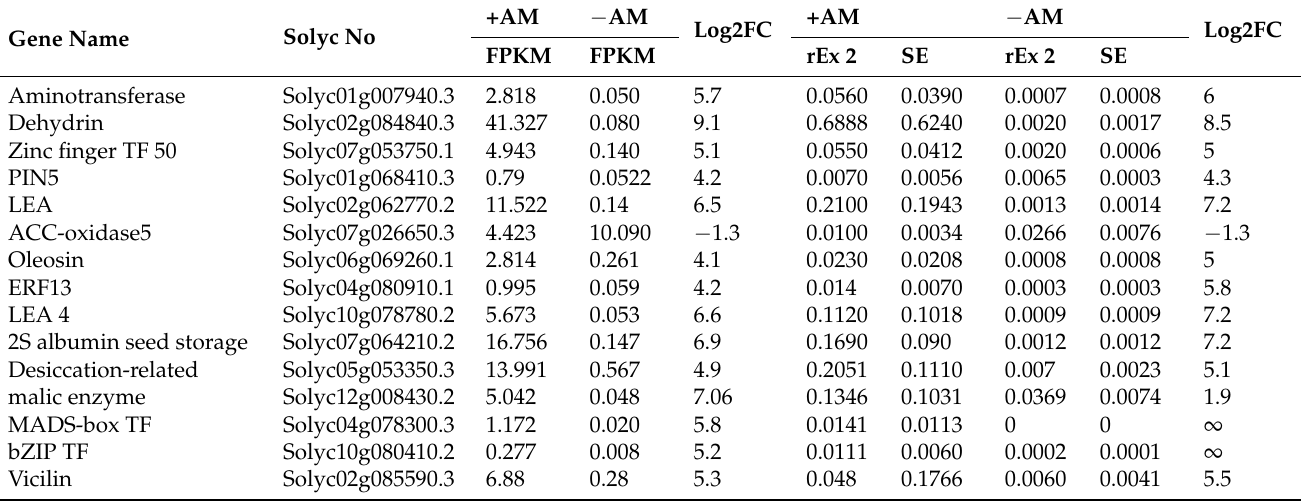
Table 1. Selected DEGs’ expression levels in green fruits of plants with and without